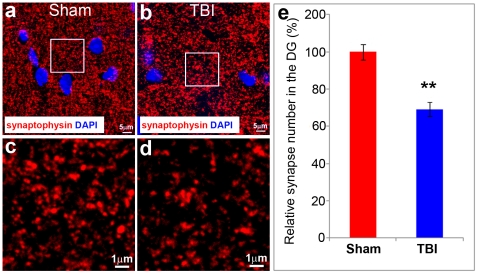
Moderate TBI decreases the number of synapses in the injured area.Synaptophysin staining (red) reveals the pre-synaptic puncta in the molecular layer of the HDG in control (a, c) and moderate TBI mice (b, d). Quantitative data showed a significant decrease of synapses in the HDG of injured mice (e). (n = 5, **, p<0.01).